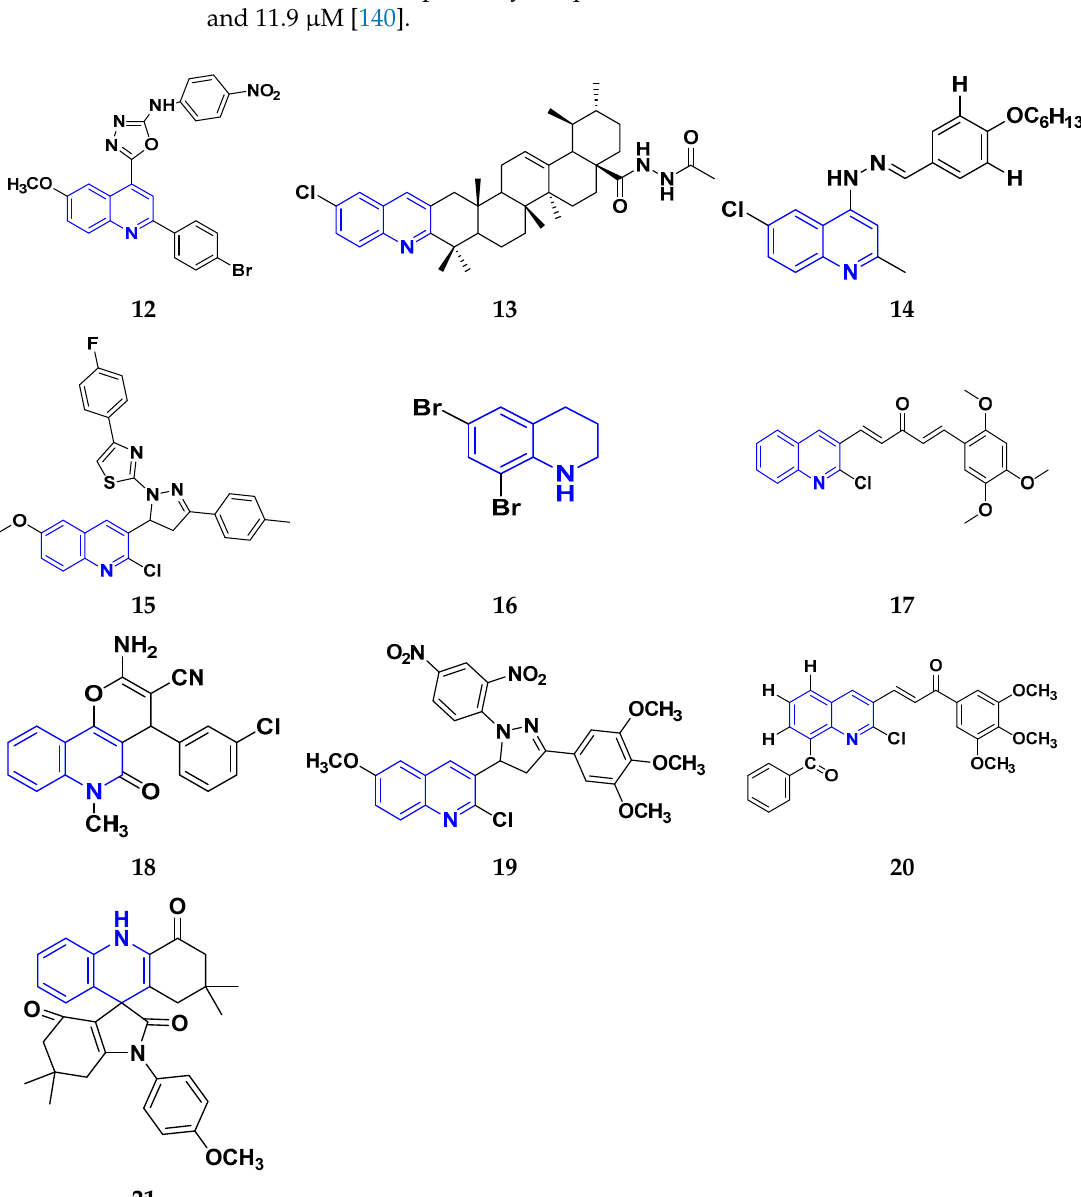
Figure 4. Quinoline derivatives ( 12 – 21 ) as anticancer agents.